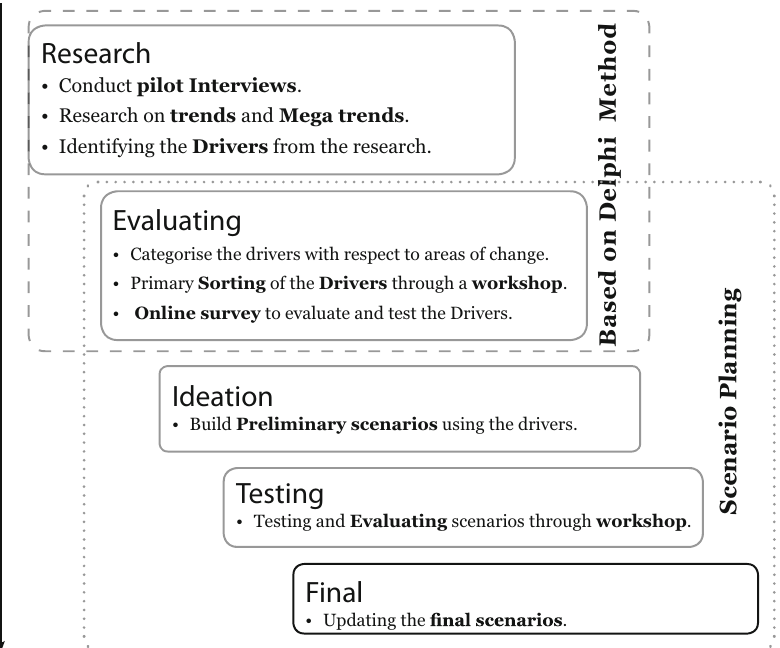
Fig. 1 Description of the